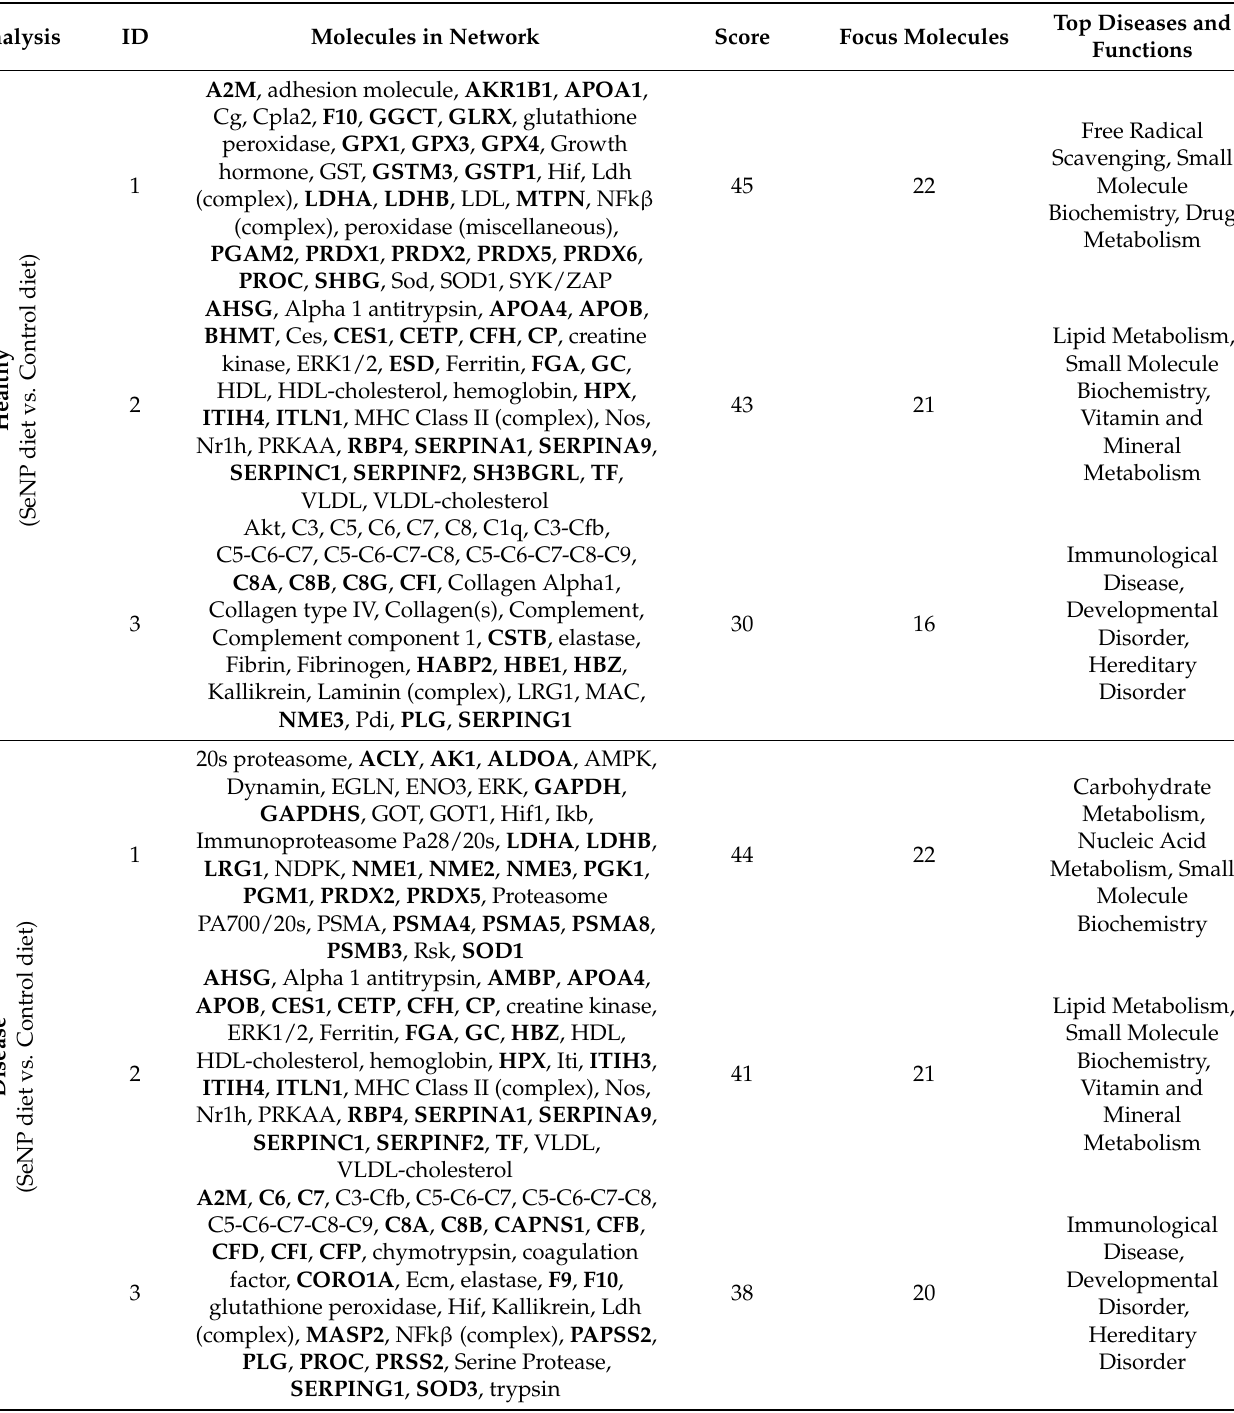
Table 1. The top three molecular networks based on differentially expressed proteins (DEPs) compar- ing the two diets under healthy and diseased conditions, respectively. DEPs are indicated in bold text. Molecules in Network Score Focus Molecules